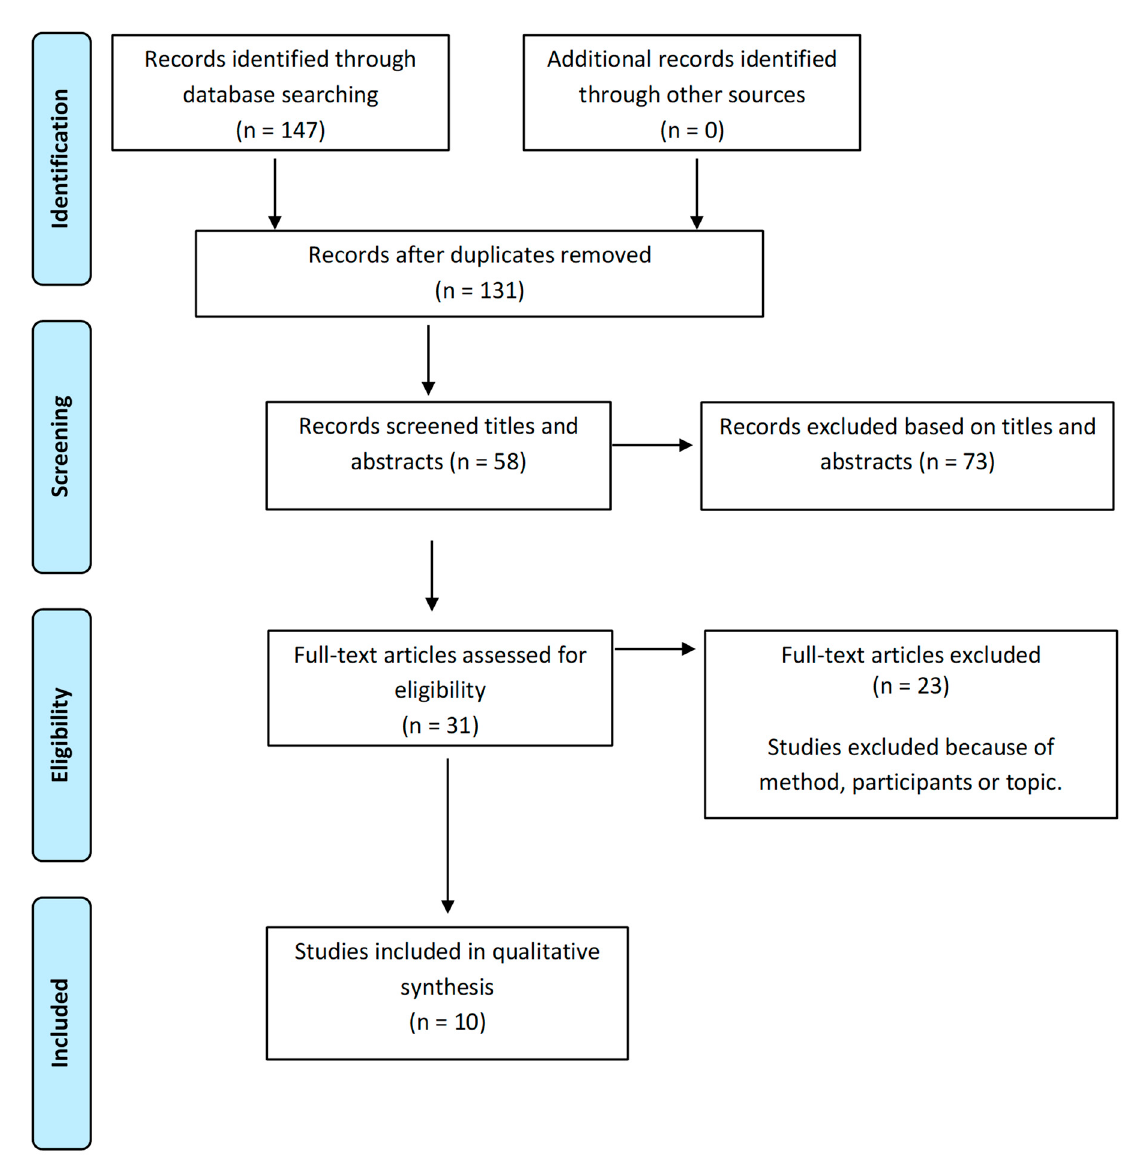
Figure 1. PRISMA Flow-Diagram of Screening Process for Review.